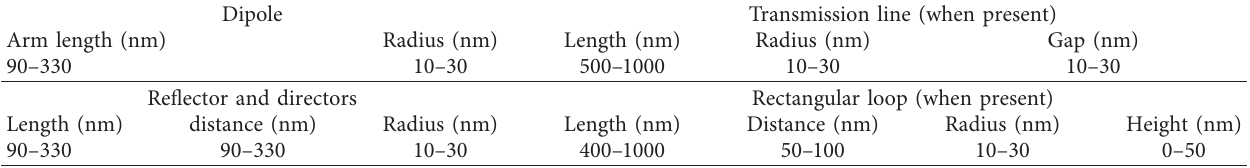
Table 2: Search space for each dimension of the elements of the conventional YU nanoantenna.